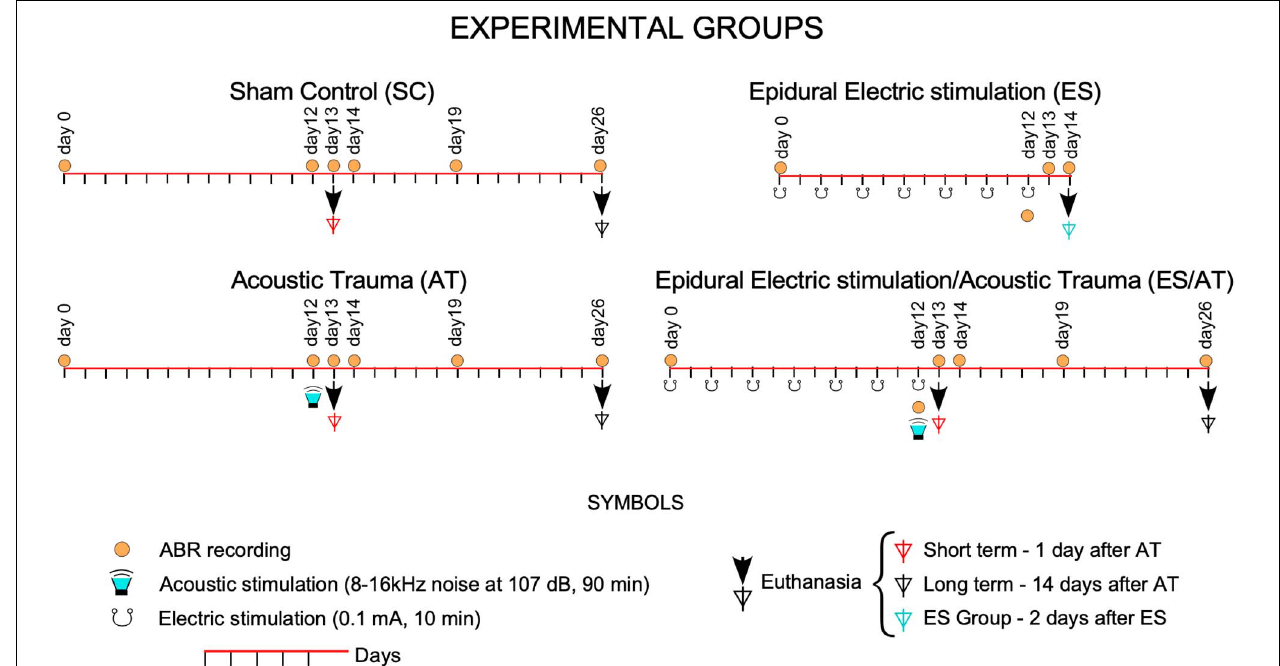
FIGURE 1 | Experimental groups: Timeline of intervention protocols. Over the line of time (red lines), day 0 labels the start of the protocols at 7 days after surgery. From day 0, AT and ES/AT groups underwent acoustic overstimulation at day 12 (green loudspeakers). In groups with electrical stimulation (ES and ES/AT), the multisession protocol was applied from day 0 to day 12. Symbols of ABR recordings (orange circles) and euthanasia (arrows and triangles) were over the curve of time (line in red) following the sequence of events in the